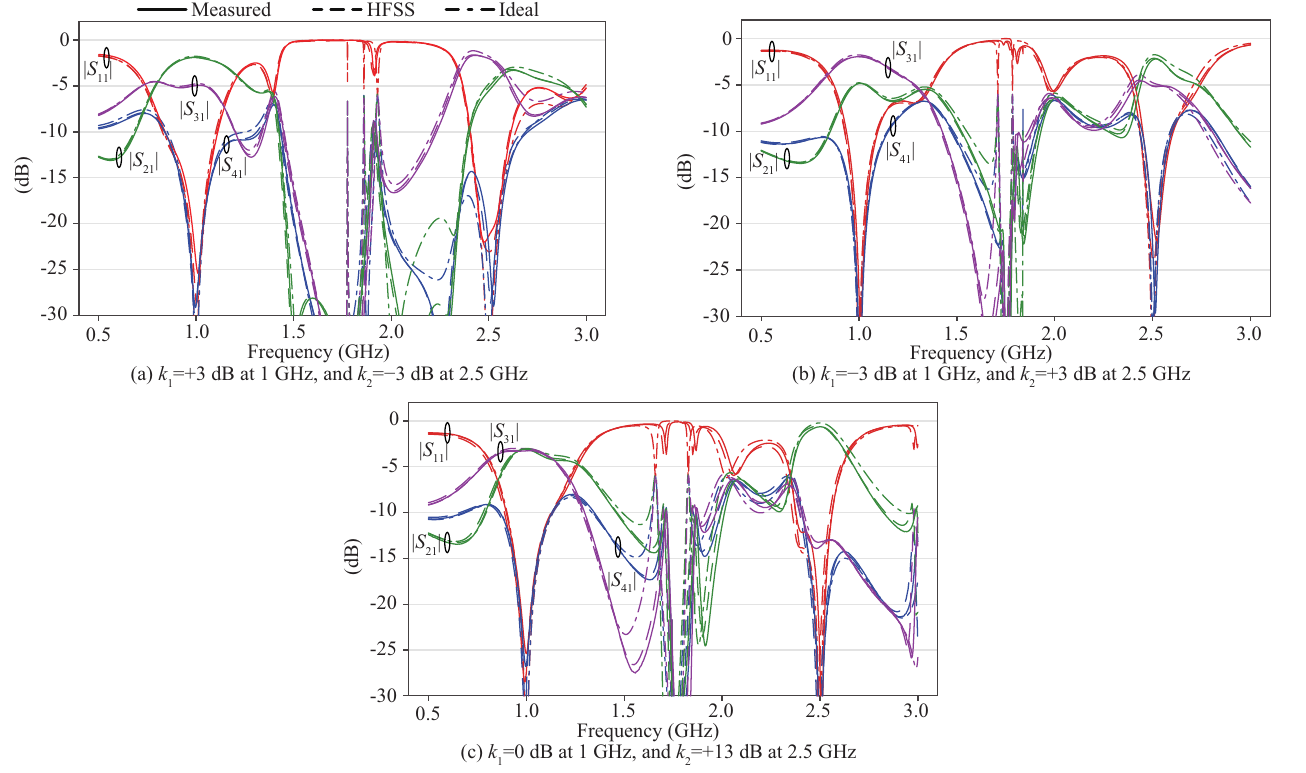
Figure 6. Measured, full-wave, and ideal circuit simulated results. ( a ) Coupler A, ( b ) Coupler B, and ( c ) Coupler